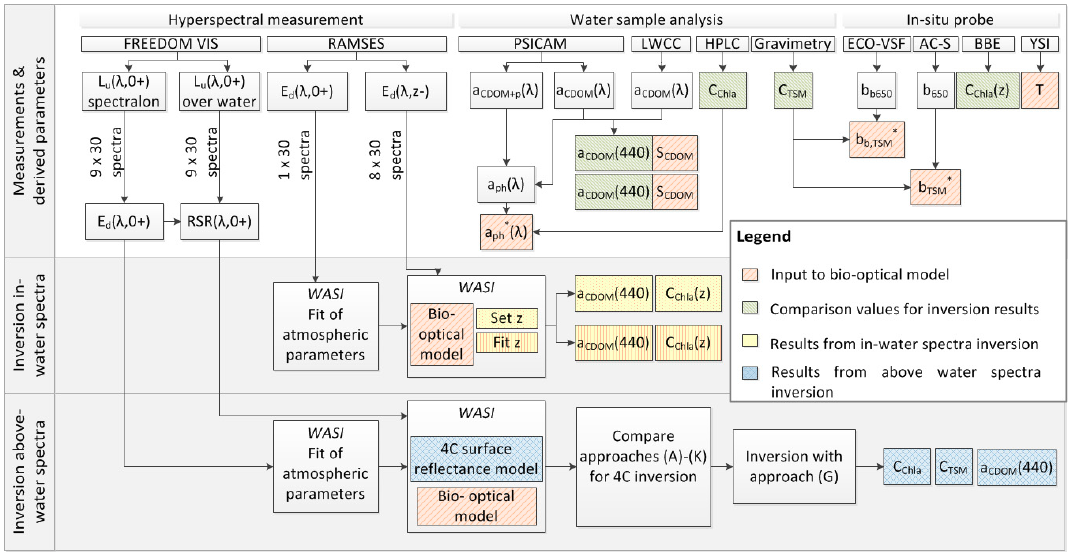
Figure 1. Flow chart illustrating the set of measurements and methodology applied in this study. All abbreviations and acronyms are defined in Sections 2.3 to 2.6, and are listed at the end of the paper.